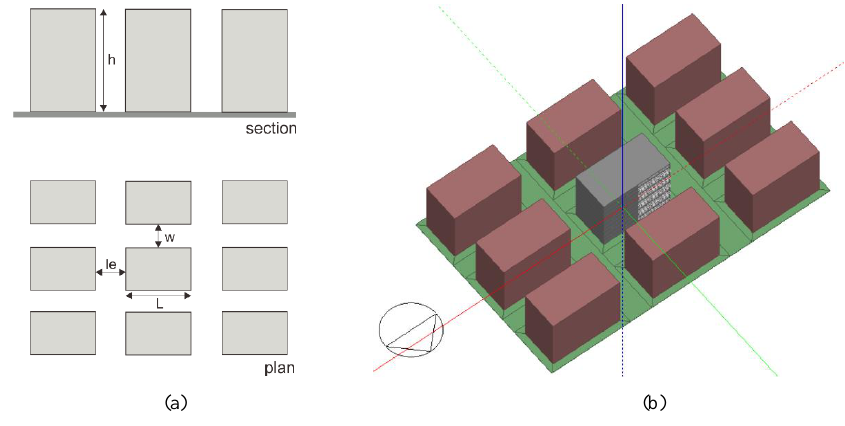
Fig. 3. (a) Urban aspect ratio or urban canyon; (b) one of the model in medium-dense urban